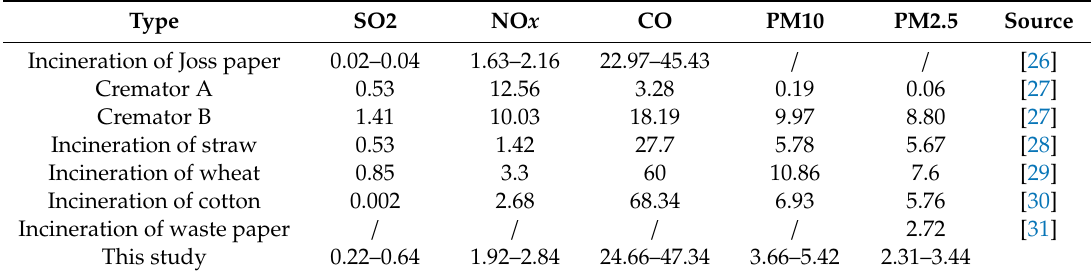
Table 3. Emission factors of air pollutants from the incineration of four types of sacrificial o ff erings and relevant sources Unit: kg t −